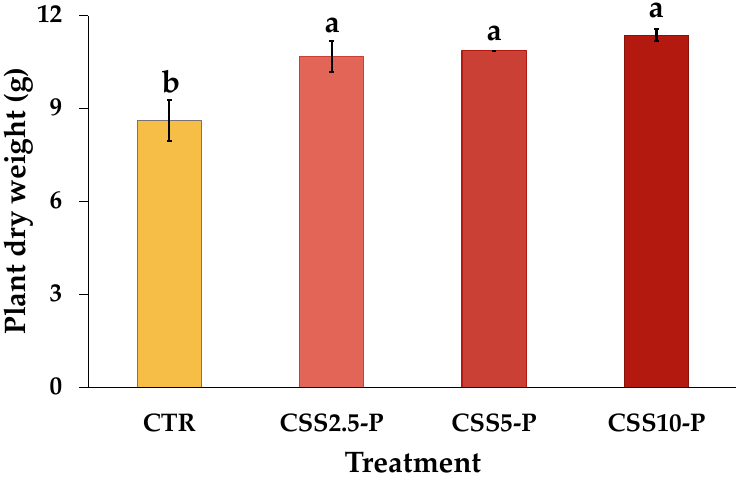
Figure 2. Plant dry weight of lettuce in soil amended with different doses of CSS: control (CTR), 2.5 t ha − 1 (CSS2.5-P), 5 t ha − 1 (CSS5-P), and 10 t ha − 1 (CSS10-P). Different letters indicate significant differences among treatments at p < 0.05.